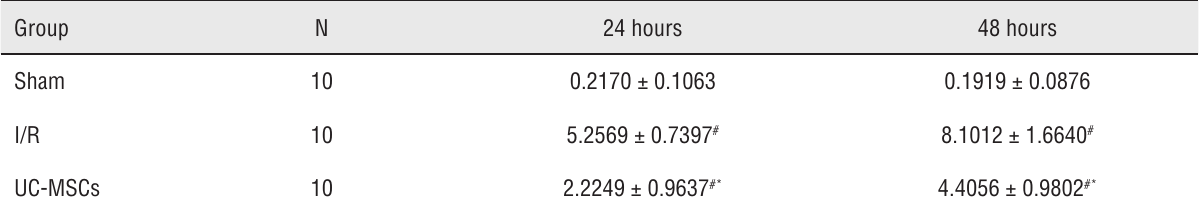
Table 2 - ICAM-1expression in renal tissue at different time in all groups. Group N 24 hours 48 hours Sham 10 0.2170 ± 0.1063 0.1919 ± 0.0876 I/R 10 5.2569 ± 0.7397 # 8.1012 ± 1.6640 # UC-MSCs 10 2.2249 ± 0.9637 #* 4.4056 ± 0.9802 #* Note: #P < 0.01 vs. sham group; *P < 0.01 vs. I/R group.